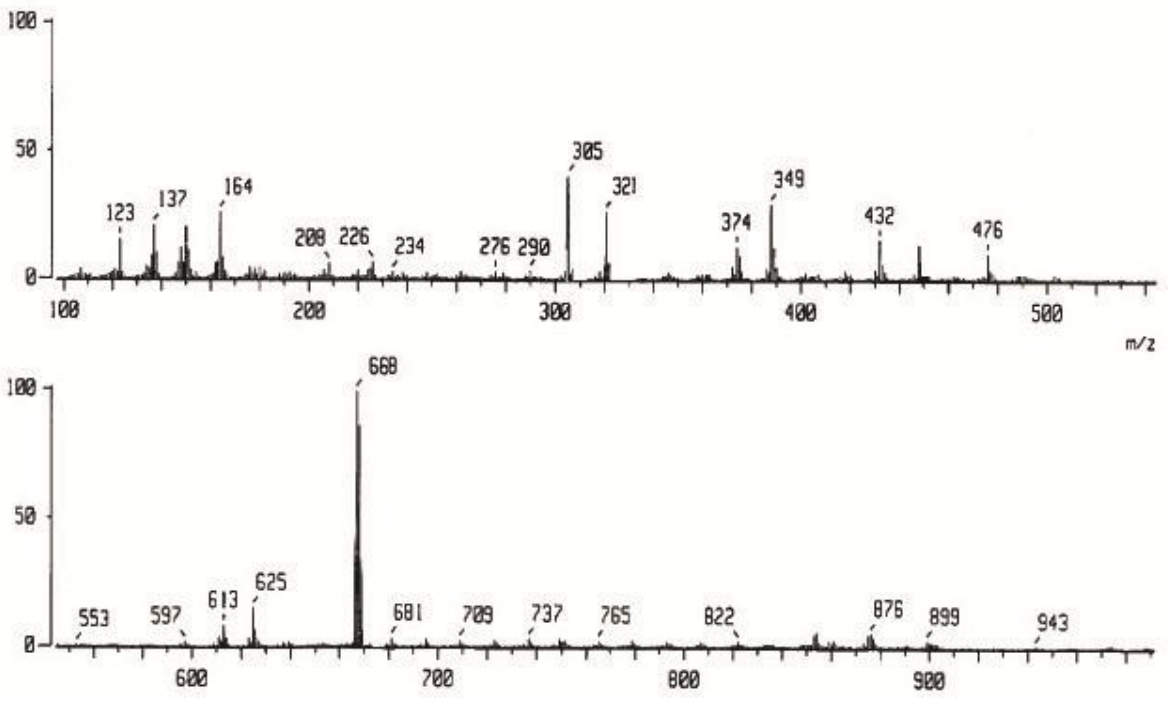
Fig. S5 – FAB Mass Spectrum of ligand, H